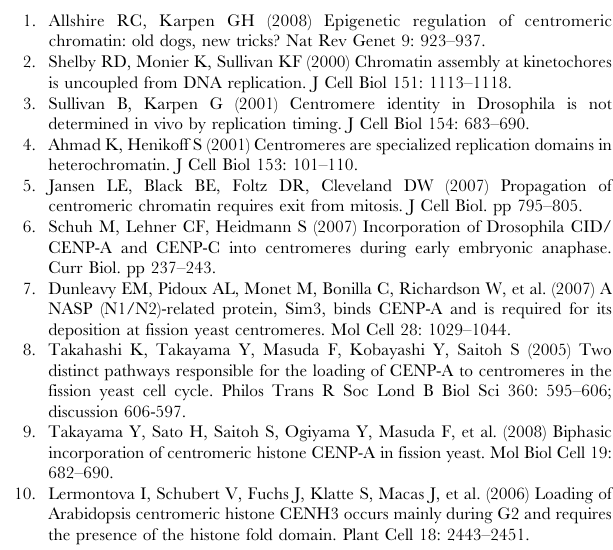
Figure S6 Quantification of new CID loading in arrested interphase cells and SNAP-CID loading visualized 1 h after BTP-block. A) Representative images of interphase and mitotic SNAP-CID cells that were TMR labeled immediately after the BTP block (left panel). In both groups, 91% of cells were negative for any TMR-CID at the centromere. In the right panel, representative images of cells scored as positive for TMR-CID showing the clear difference in intensity of signal between mitotic (84% positive; n =60) and interphase (36% positive; n =230) cells,